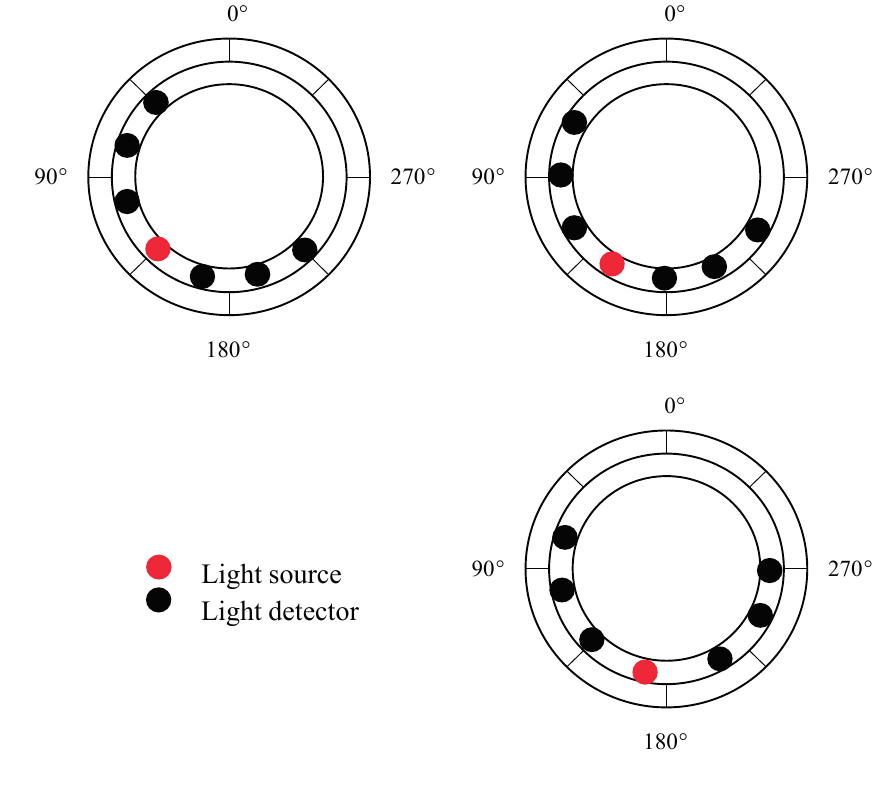
Figure 3. Three types of optical probe placements. The light source was placed at 135°, 150° and 165°,